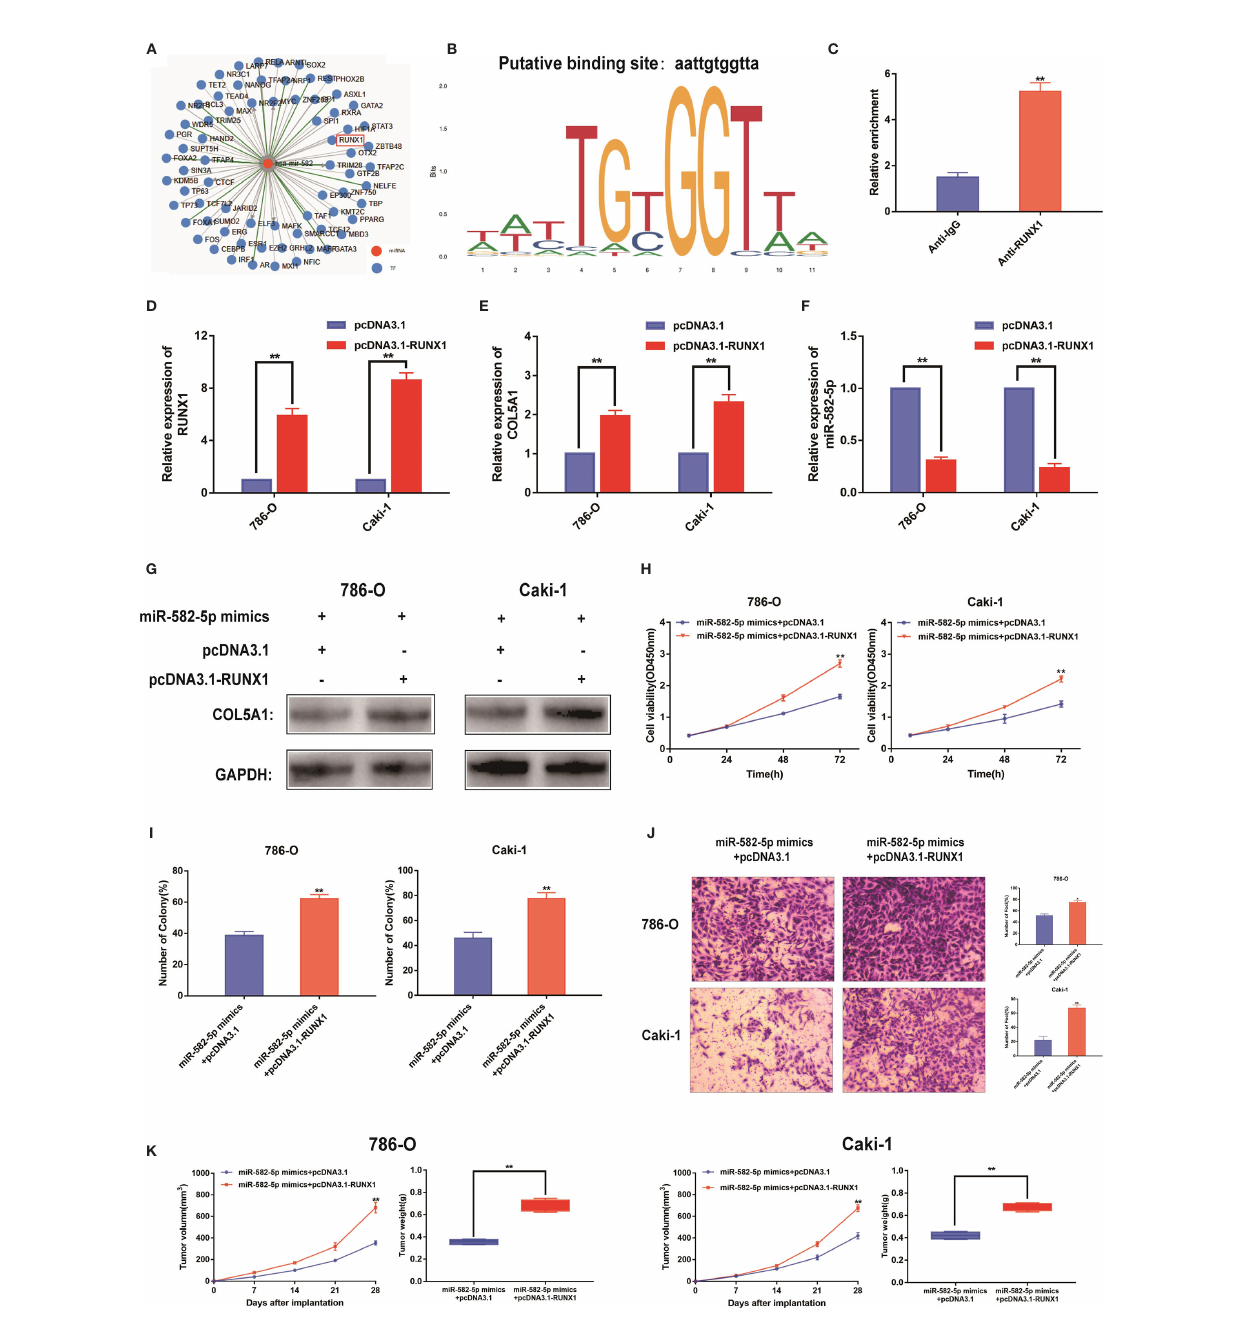
FIGURE 6 | RUNX1 was an upstream regulator of miR-582-5p. (A) The candidate upstream regulators were predicted by TransmiR database. (B) Based on TransmiR database, the putative score of RUNX1 binding to miR-582-5p was the highest. (C) ChIP assay indicated the RUNX1 binds to the putative binding site upstream of miR-582-5p. (D) The effect of overexpression RUNX1 by pcDNA3.1 was identi fi ed by qRT-PCR. (E, F) Levels of miR-582-5p and COL5A1 responding overexpression RUNX1 were detected by qRT-PCR. (G) Expression levels of COL5A1 in 786-O and Caki-1 cells which co-trnsfected with miR-582-5p mimics and pcDNA3.1-RUNX1 (or pcDNA3.1) were detected by western blot. GAPDH was used as an internal control. (H, I) CCK-8 and colony-formation assays were the in fl uence of 786-O and Caki-1 cells which co-transfected with miR-582-5p mimics and pcDNA3.1-RUNX1 (or pcDNA3.1) on cell proliferation respectively. (J) Cell invasion was determined after co-transfected with miR-582-5p mimics and pcDNA3.1-RUNX1 or pcDNA3.1. (K) Tumor volume and weight were calculated of the xenograft tumors in subcutaneous xenograft mouse model injected with 786-O and Caki-1 cells co-transfected with RUNX1 and miR-582-5p mimics or co- transfected with vector and miR-582-5p mimics respectively. The data are shown as the mean ± SD (* P < 0.05; ** P < 0.01). The experiments were repeated three times with similar